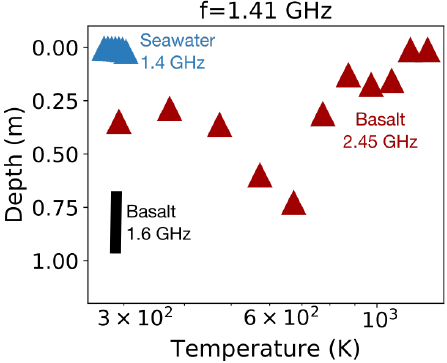
Figure 5. Absorption length at the SMAP frequency as a function of temperature for basalt rock at 1.6 GHz (black; Ulaby et al. [35]), basalt rock at 2.45 GHz (red; Hartlieb et al. [31]), and seawater at 1.4 GHz (blue; Lang et al. [32]). Ulaby et al. [35] values are shown for a range of porosities, which control the real (but not imaginary) component of the dielectric permittivity. Real and imaginary components of the dielectric constant used to calculate absorption length are taken from the respective